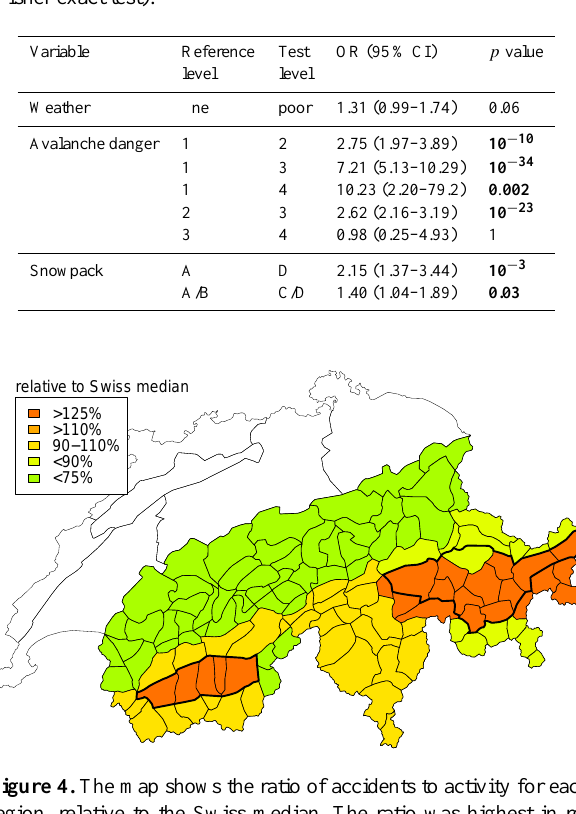
Table 4. Odds ratios for the comparison between activity (expected frequencies) and accident data (observed frequencies). Given are the odds ratio (OR), the 95% confidence interval (CI) and the p value (Fisher exact test).